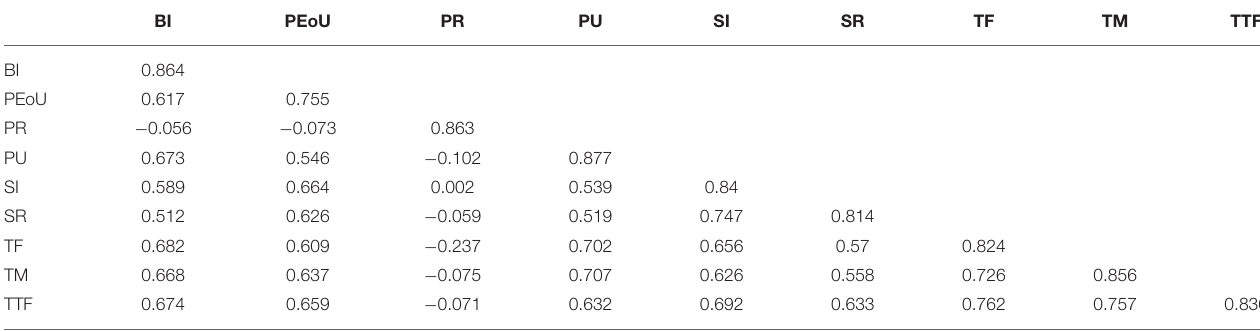
TABLE 6 | Factor correlation coefficients and square roots of average variance extracted (AVE) values*. BI